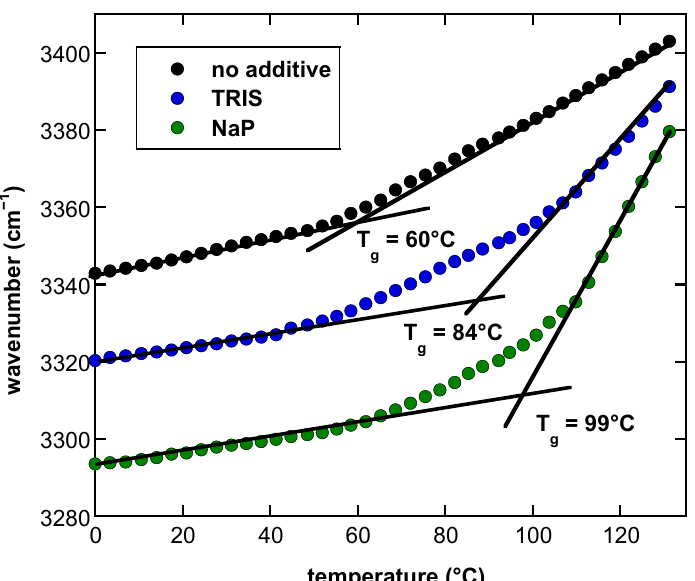
Figure 2. Melting curves of dry Suc glasses determined from the temperature-induced shift of the position of the ν OH peak in FTIR spectra. Suc at a final concentration of 10 mg/mL was dissolved in pure H 2 O, in Tris or NaP buffer (10 mM, pH 7.4) and dried on CaF 2 windows. Glass transition temperatures (T g ) were determined from the intersection of fitted regression lines in the glassy state at low and the melted state at higher temperatures. T g of the different samples is indicated.